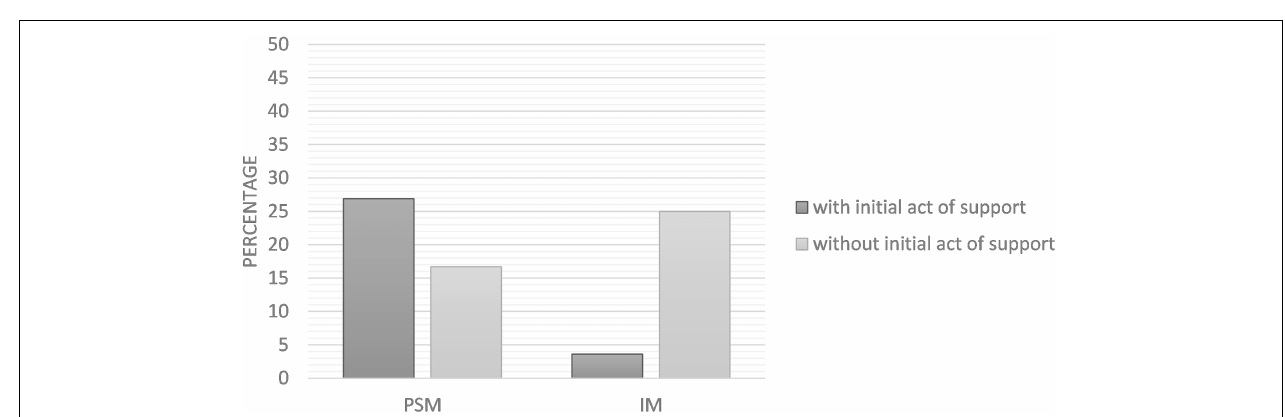
FIGURE 5 | Scores of intention to donate blood next week (Study 3). Error bars represent standard deviation.